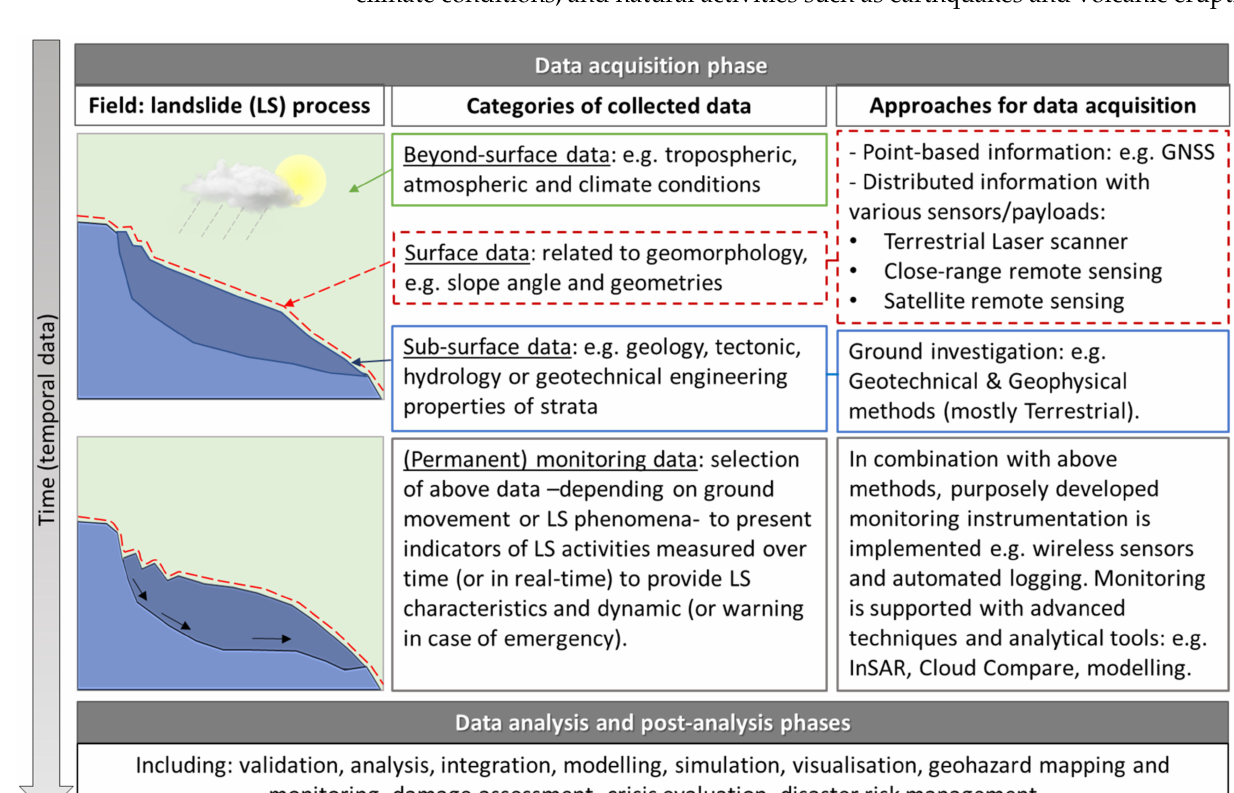
Figure 1. Overview of the data acquisition phase and categories of data collected for landslide studies and relevant